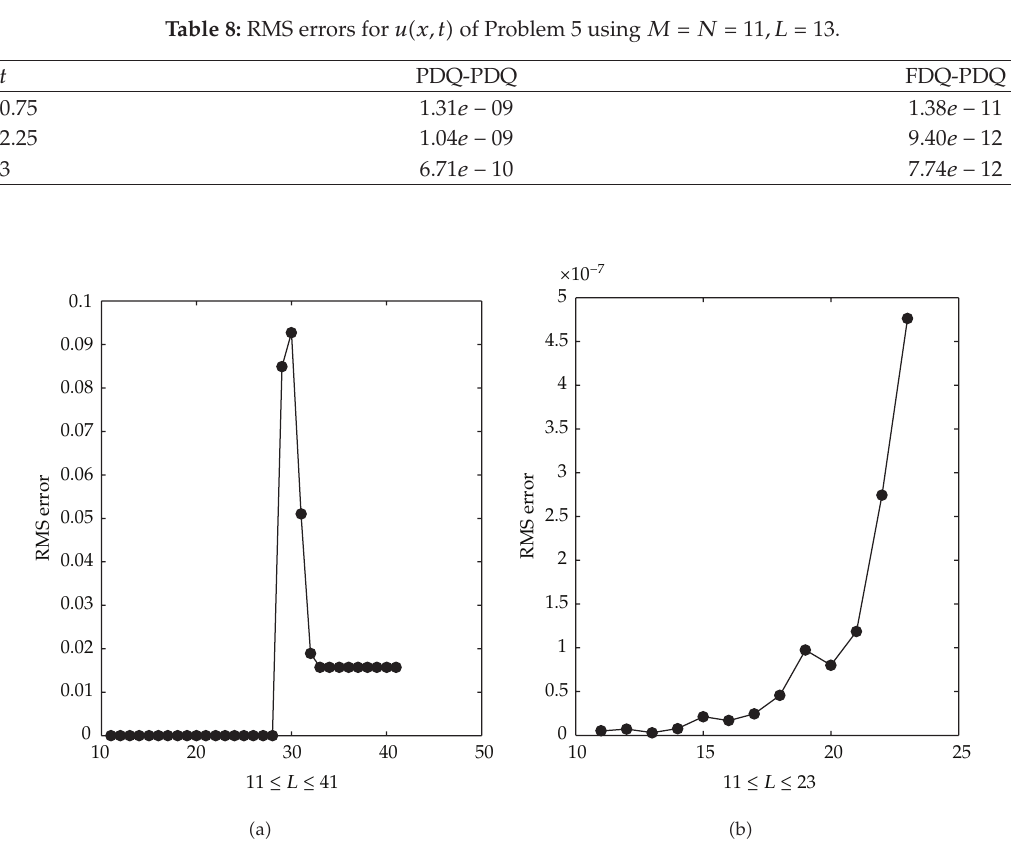
Figure 2: RMS errors at T versus ES grid points in time direction for Problem 4.